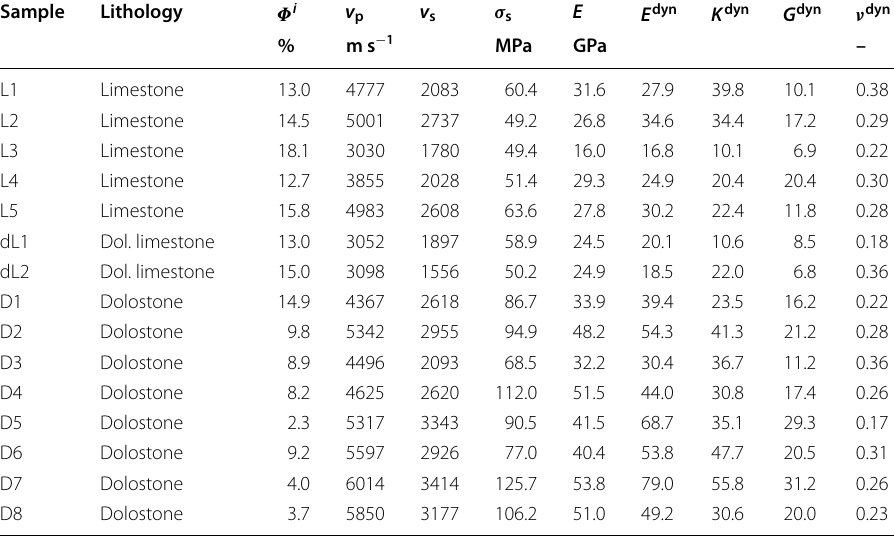
Table 3 Geomechanical characteristics of the investigated rock samples from dynamic and static